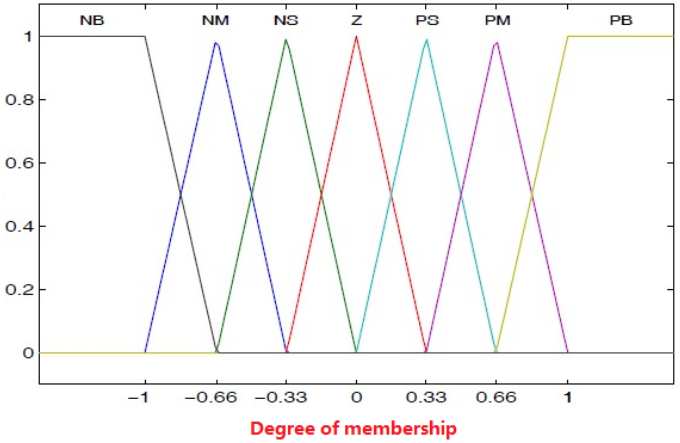
Figure 4. Input and output membership functions of the fuzzy